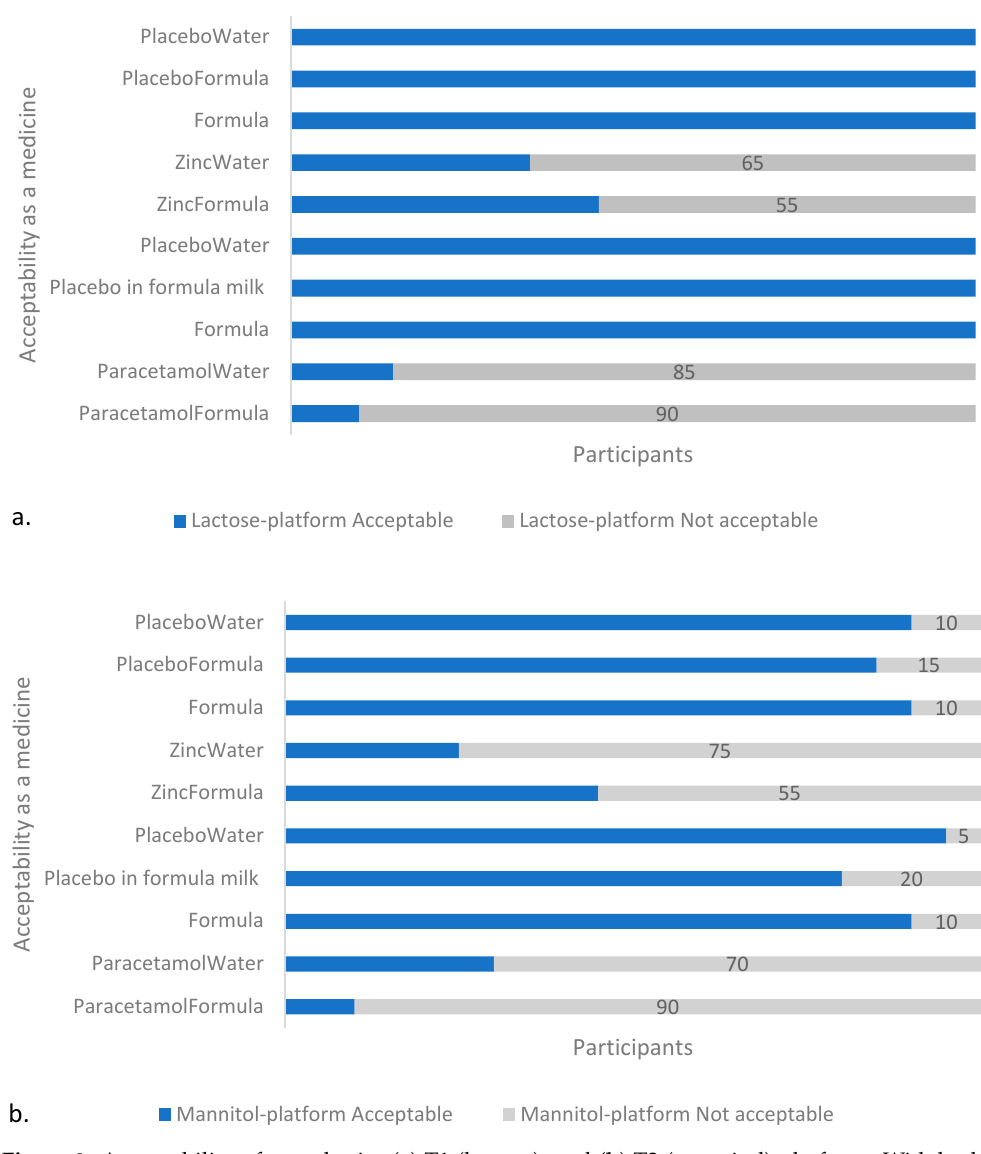
Figure 3. Acceptability of samples in: ( a ) T1 (lactose), and ( b ) T2 (mannitol) platform. With both platforms, the API-containing samples were assessed by the majority ( ≥ 55%, n = 20) of participants as unacceptable as a medicine, with the paracetamol-containing formulations unacceptable to the greater majority ( ≥ 70%, n = 20). Note: Formula and PlaceboWater appears twice on the y-axis to account for the two separate sessions (on two different days) with the two different APIs per platform in which they were used as placebos and reference samples, respectively.